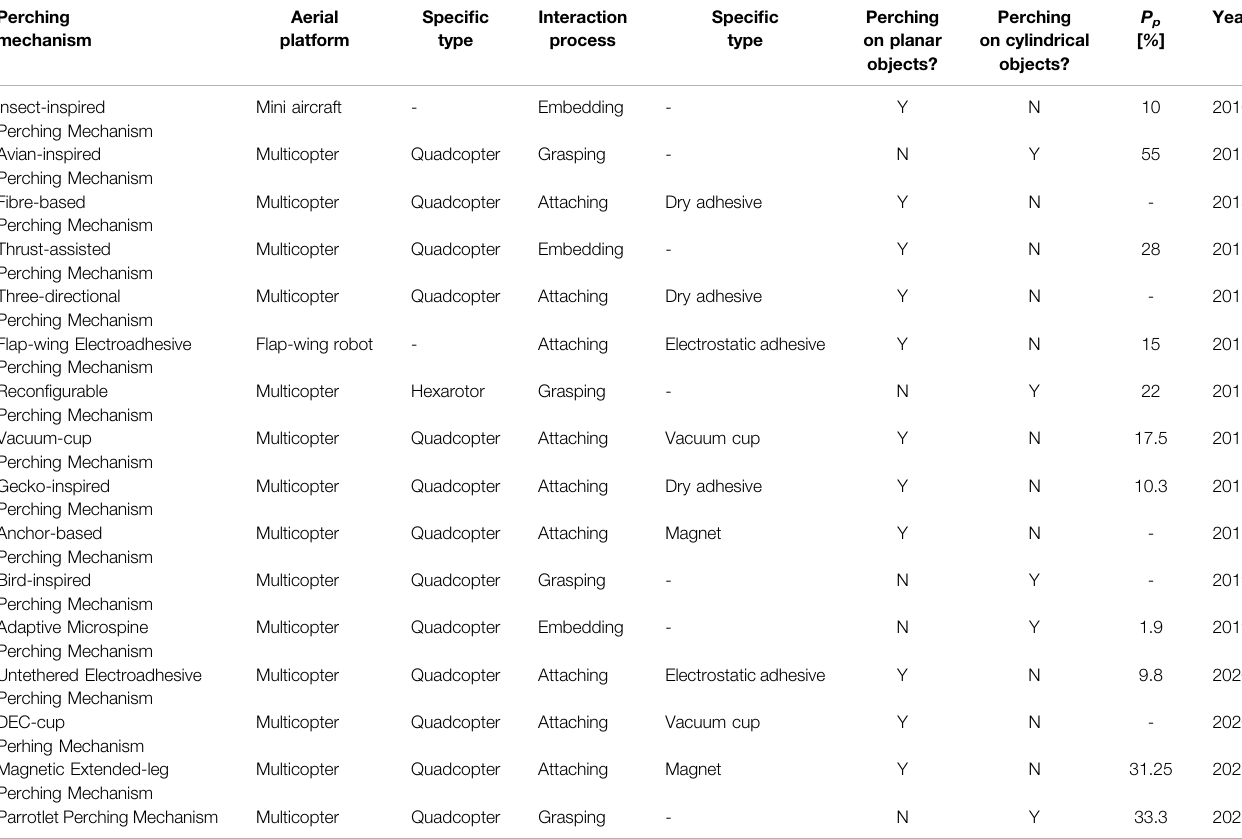
TABLE 4 | Comparison of characteristics of the examined aerial manipulators for aerial